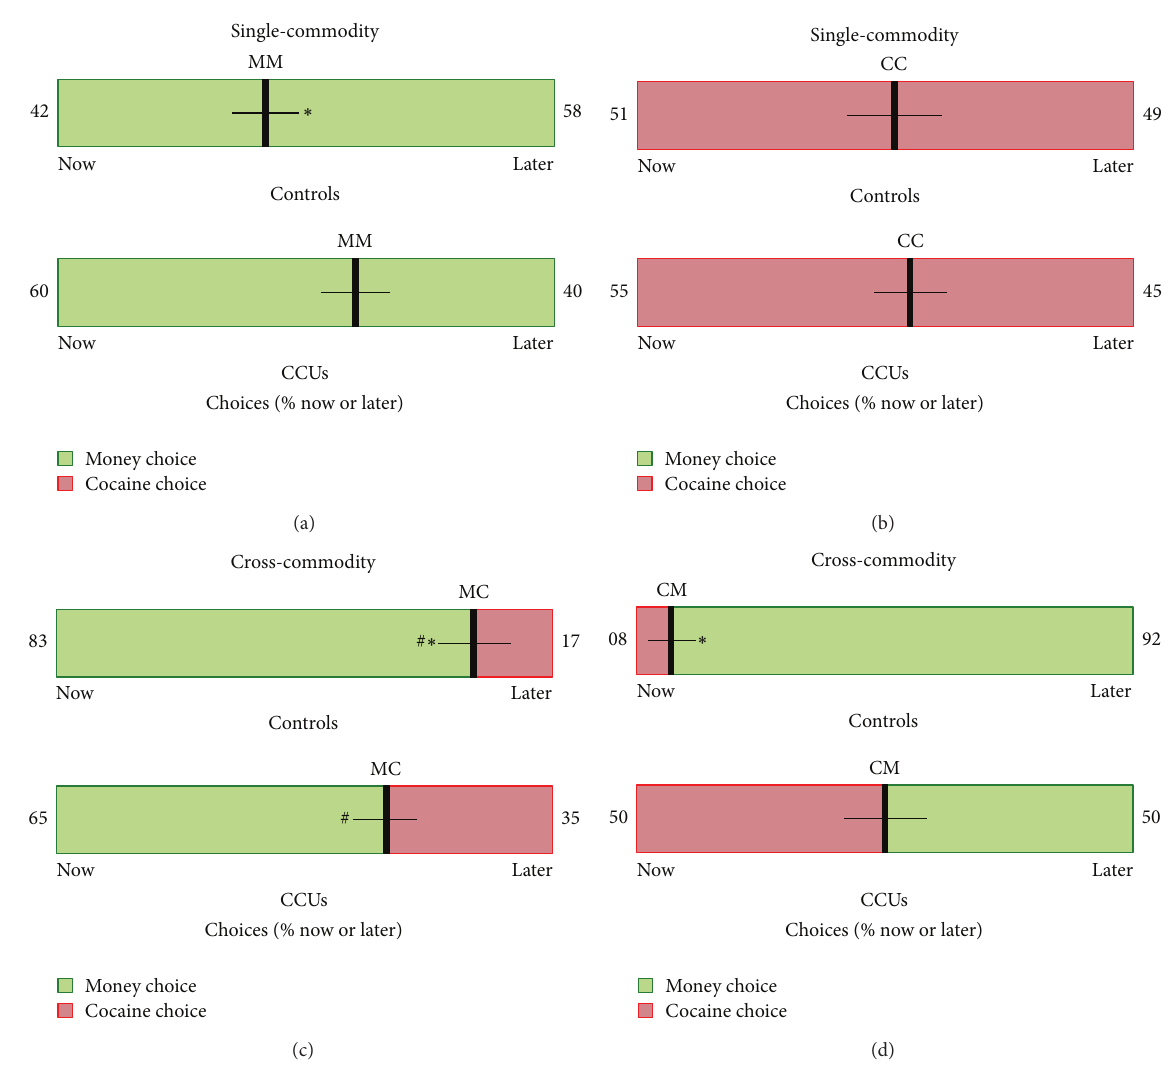
Figure 4: Money and cocaine choices. Data are the averaged ( ± SEM) percentages of immediate (now) and future (later) choices in controls (Controls) chronic cocaine users (CCUs). Single-commodity choice involved choosing between immediate or future money (MM) or cocaine (CC), and cross-commodity choice involved choosing between immediate money and future cocaine (MC) or between immediate cocaine and future money (CM). Money and cocaine choices are green and red, respectively. CCUs made fewer choices for future money, compared to Controls (MM and CM). In cross-commodity tasks, CCUs chose cocaine more than Controls. Regardless, a large portion of the choices were for money (MC = 65% and CM = 50%). Incentivizing the future with money resulted in a 15% increase in future choices in CCUs away from the immediate cocaine option (MC = 35% versus CM = 50%). ∗ Difference between groups, within task, 𝑃 < 0.01 ; # difference, within group, between cross-commodity tasks, 𝑃 < 0.05